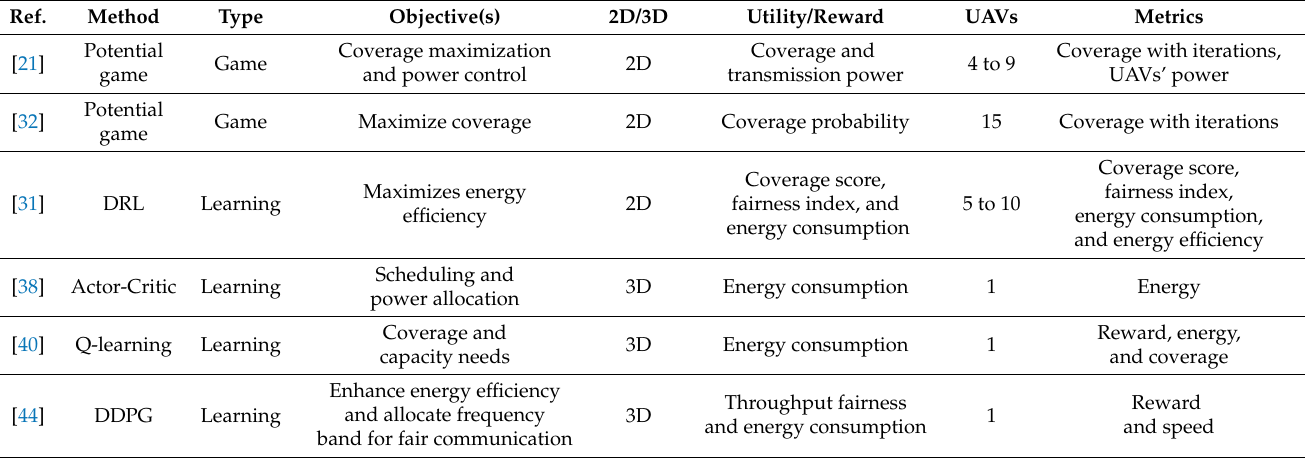
Table 1. Literature summary of game- and learning-based